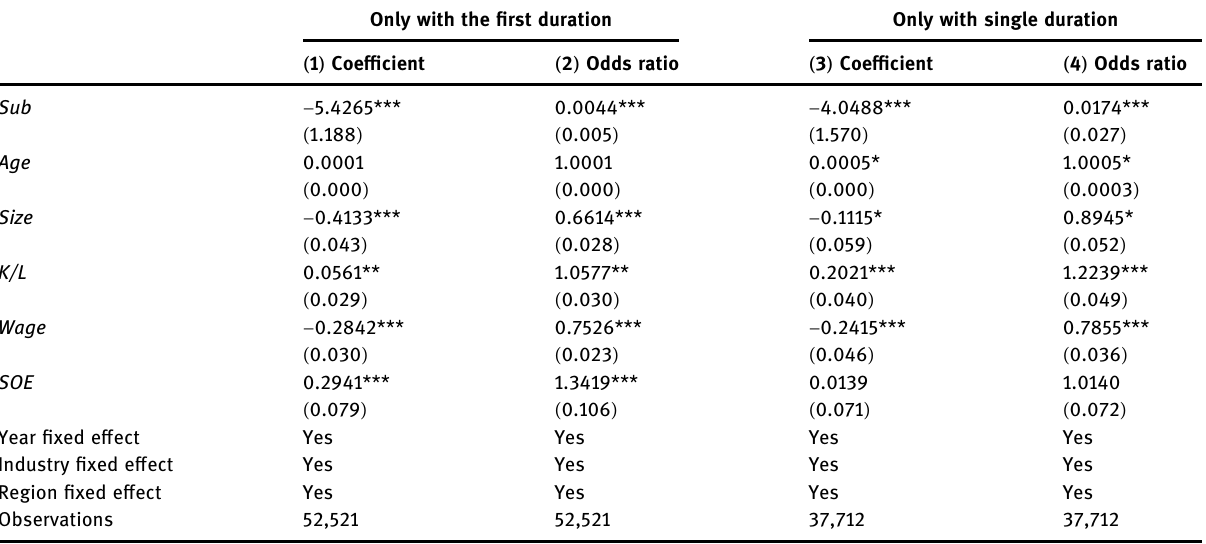
Only with the fi rst duration Only with single duration